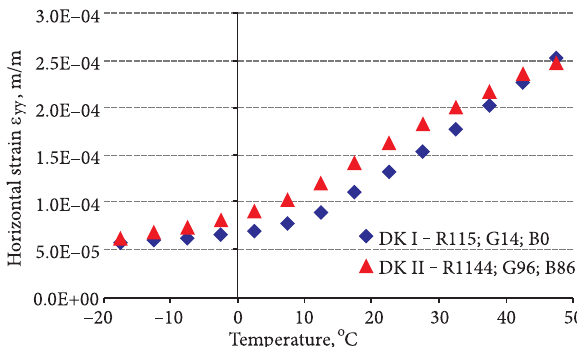
Fig. 5. The horizontal strain depending on pavement surface temperature